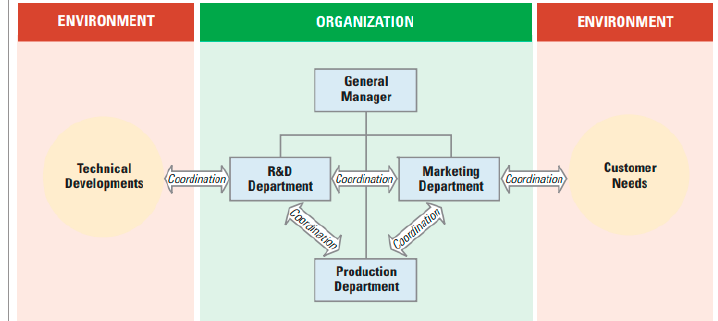
Figure 26. Richard Daft’s company organization concept (2010).